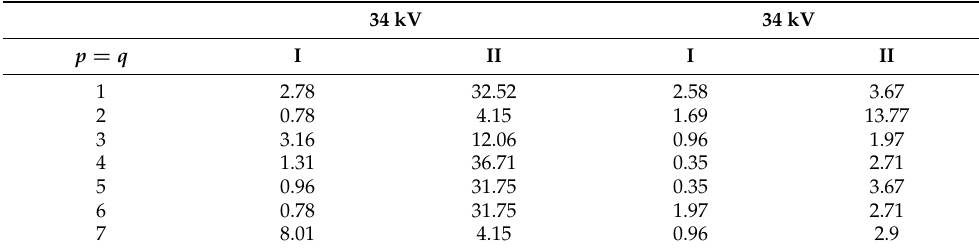
Table 13. RSS for failure times of insulating fluid data with set sizes n = m = 2. 34 kV 34 kV